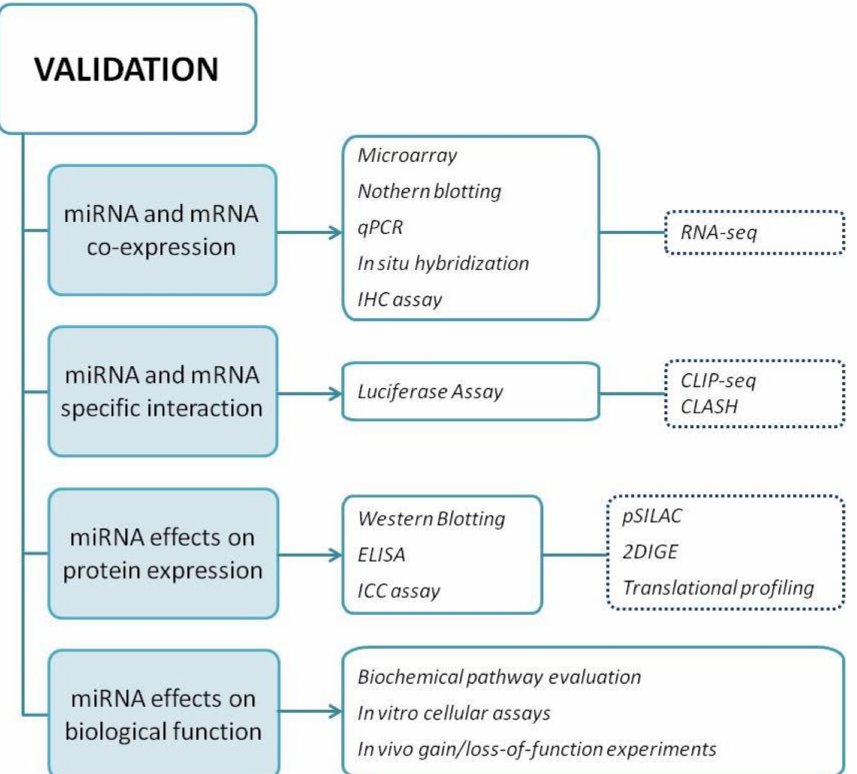
Figure 5. Summary of miRNA validation approach. In the flowchart, all experimental procedures that need to be performed in order to meet the four criteria required for miRNA validation are indicated. Dotted rectangles indicate methods belonging to High-Throughput